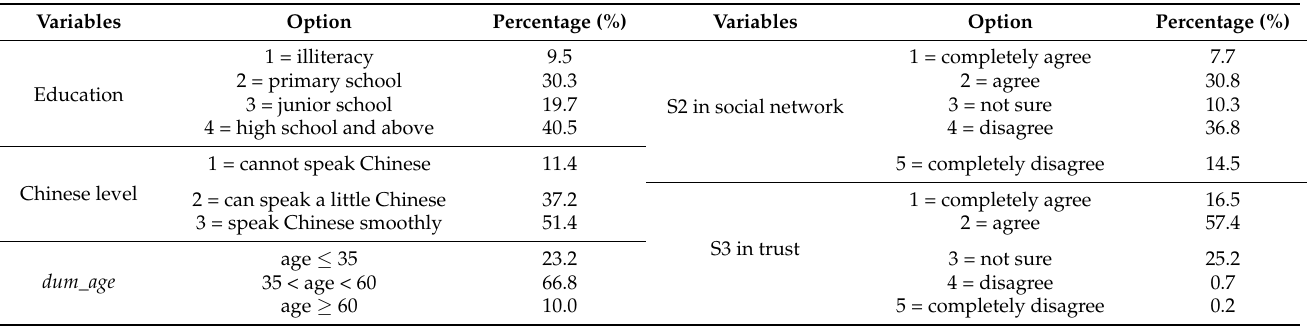
Table 4. Descriptive statistics of variables.